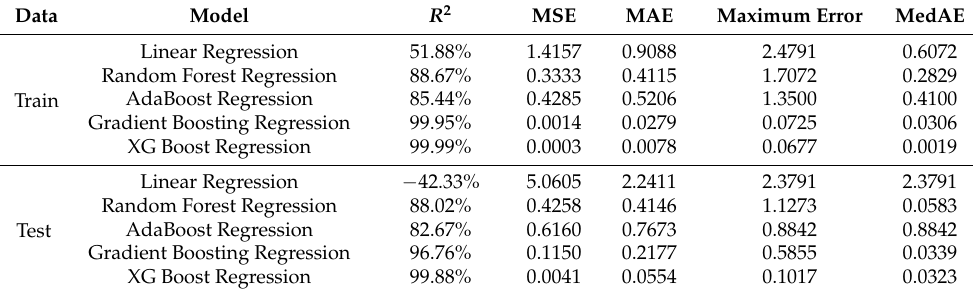
Table 2. Performance of the machine learning models on Zn (g/L) data.